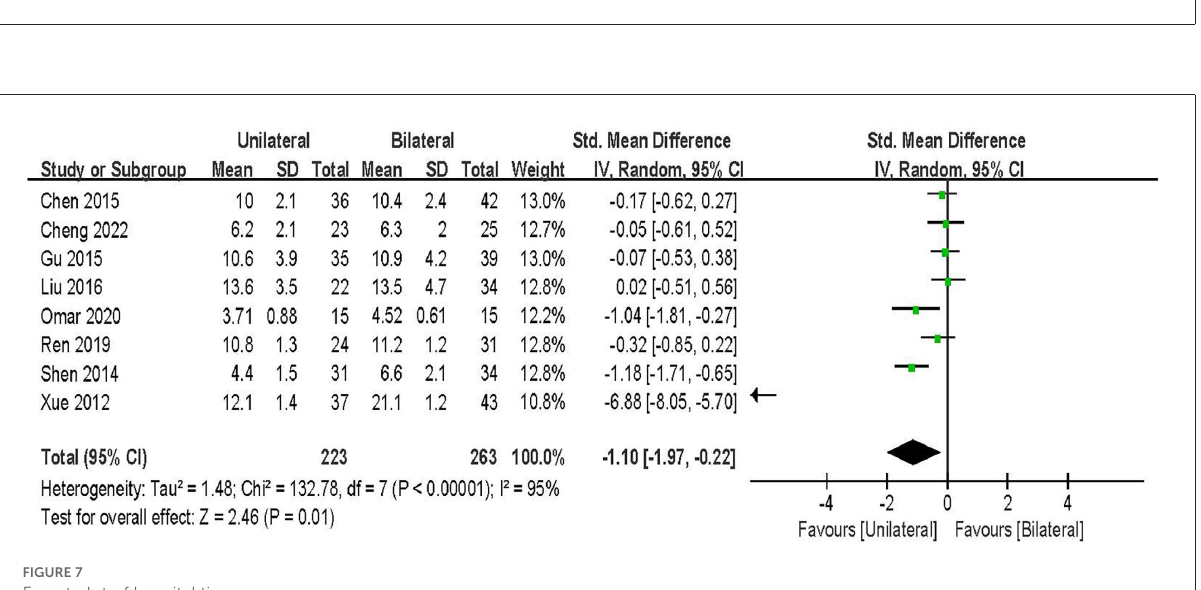
FIGURE6 Forest plot of operation time.